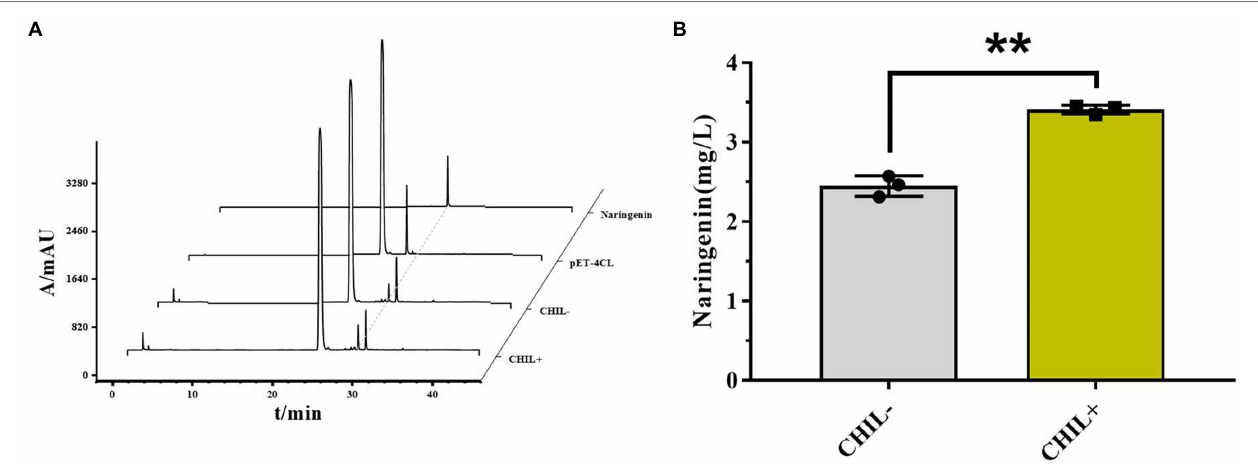
FIGURE 7 | AfCHIL in the biosynthesis of naringenin from p -coumarin acid. (A) HPLC of catalyzed reactions during the production of naringenin from p -coumaric acid in Escherichia coli carrying pET15b-4CL (negative control), pET15b-4CL-CHS-CHI (CHIL − ) and pET15b-4CL-CHS-CHI-CHIL (CHIL+) are shown. Naringenin, naringenin standard. (B) Effect of the presence or absence of CHIL on naringenin synthesis. Data are presented as the average of three independent determinations of three biological replicates (±standard error). ** p <